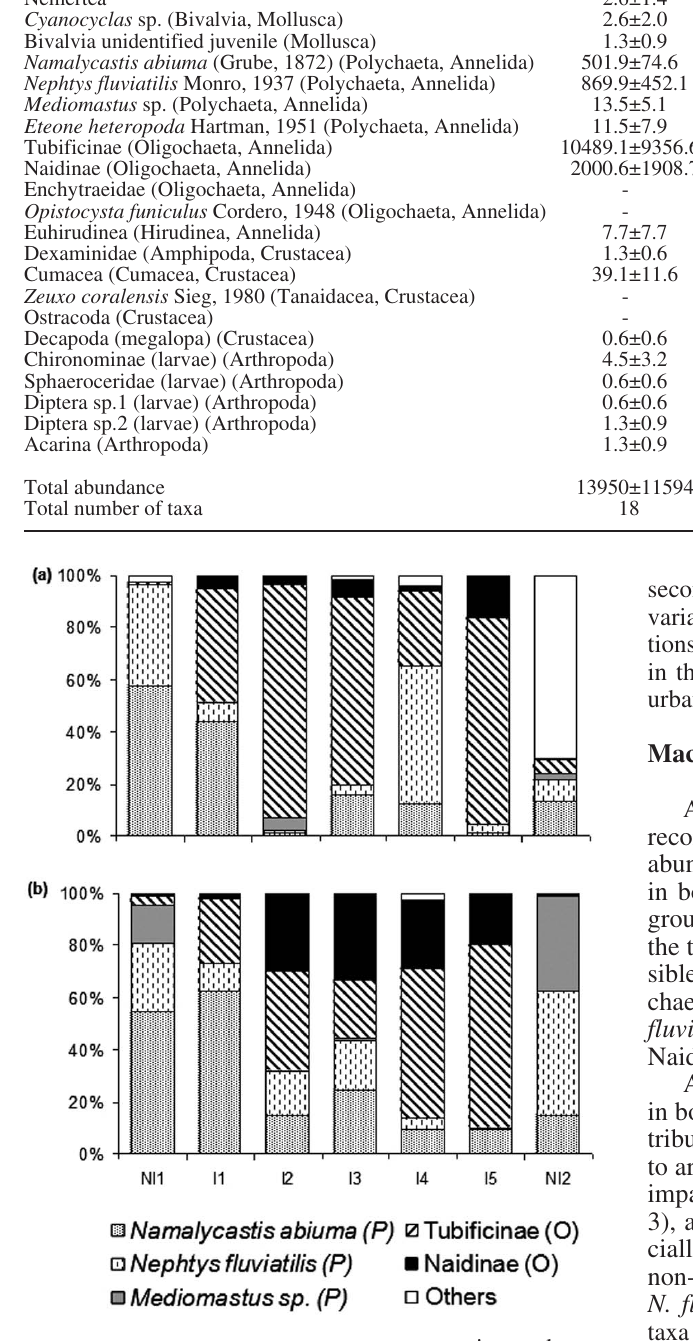
Fig . 3. – Percentage contribution of main taxa in the sites and sea- sons sampled . P, Polychaeta; O, Oligochaeta. Dry season (a) and Rainy season (b). NI, non-impacted sites; I, impacted